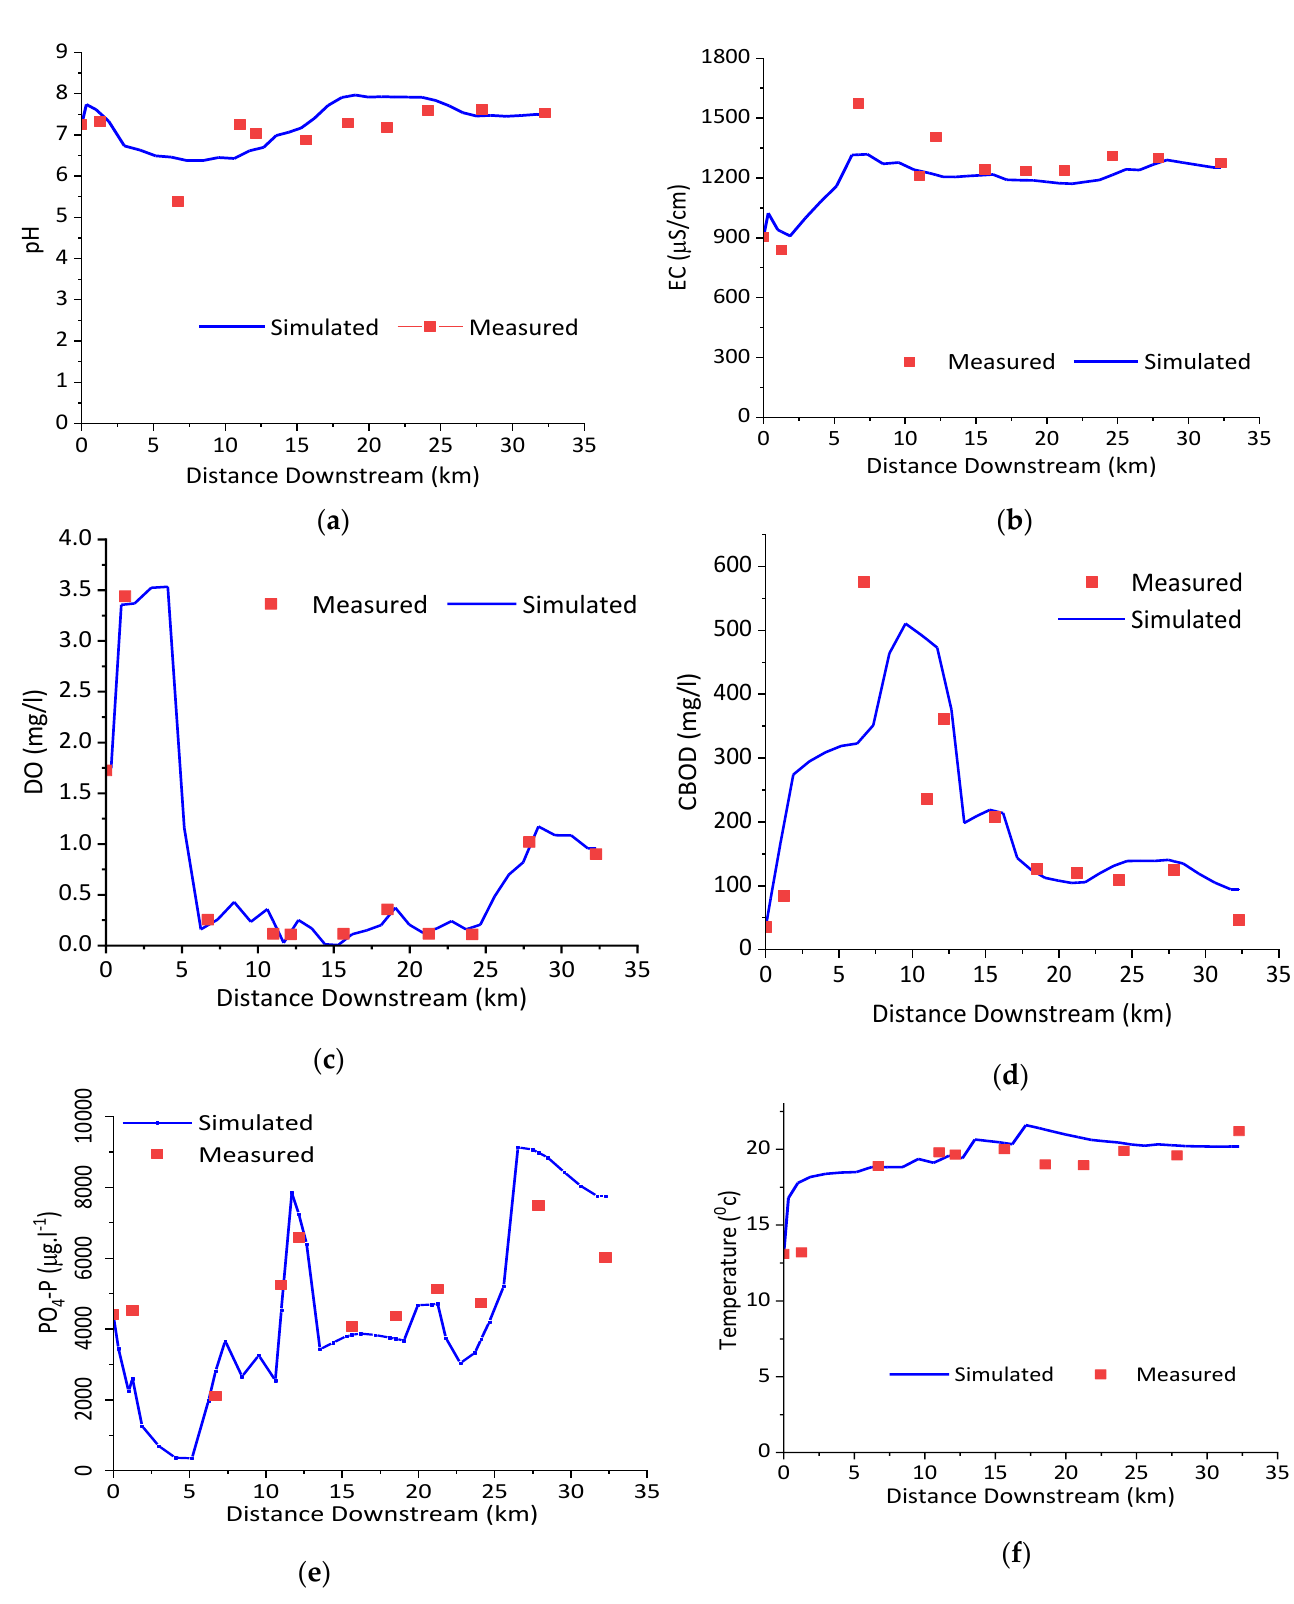
Figure 4. Simulation of QUAL2kw for selected water-quality constituents in LAR (calibration): ( a ) pH, ( b ) Electrical Conductivity (EC) ( µ s/cm), ( c ) Dissolved Oxygen (DO) (mg/l), ( d ) Carbonaceous Biochemical Oxygen Demand (CBOD) (mg/L), ( e ) Phosphate (PO 4 -P), ( f ) Temperature (°C). In spite of the marked difference between the measured and model-predicted data at some monitoring stations, the model calibration (Figure 4) and validation (Figure 5) re- sults are acceptable for developing countries with high hydrometeorological and water